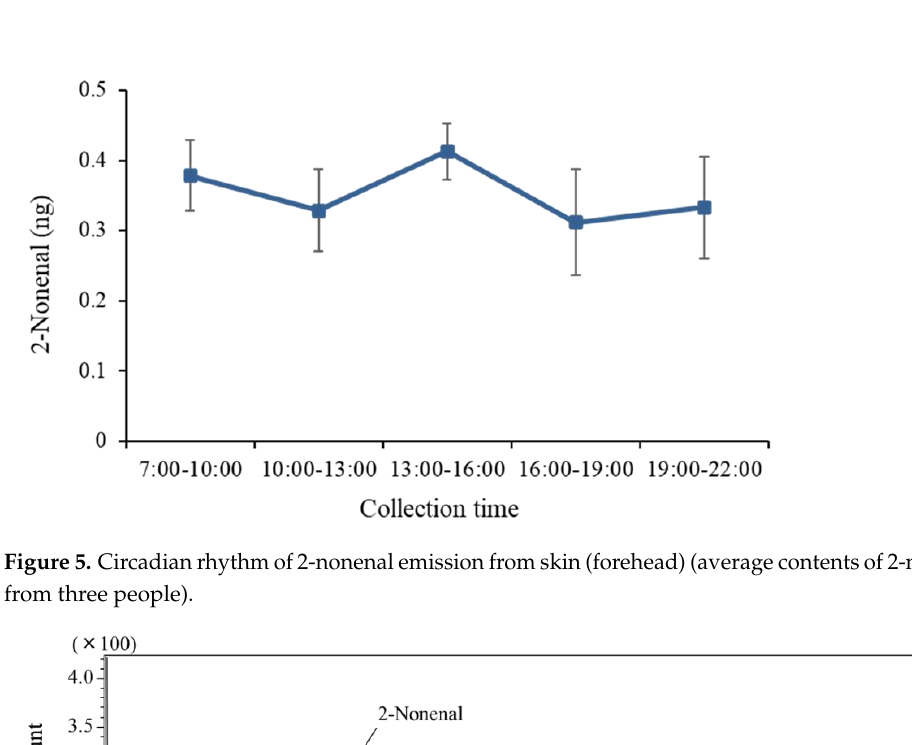
Figure 4. Comparison of 2-nonenal contents in body odor samples collected from several body